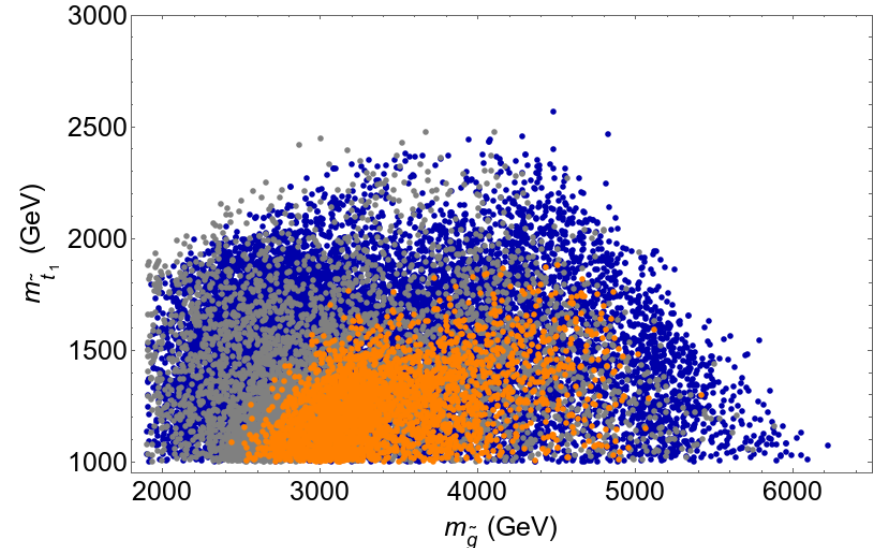
Figure 13 . A scatter plot of m ~ versus m ~ g for solutions with (cid:1) EW < 30 from the same three scans t 1 over the natural mini-landscape parameter space with m 0 (1 ; 2) ’ (2 ; 1 ; 1 = 2) (cid:2) m (cid:12)gure 10. The color scheme in this (cid:12)gure is also the same as in (cid:12)gure